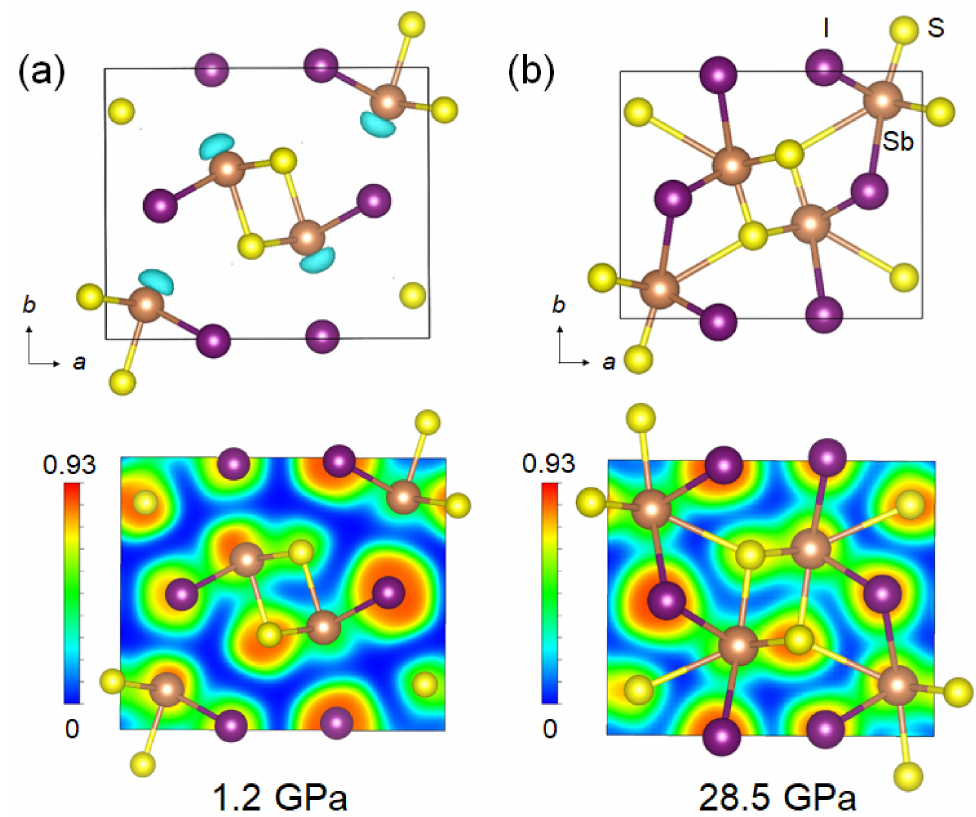
Figure 4. Electron localization function (ELF) of SbSI at different pressures. The calculated ELF plots and ELF in the (0 0 1) sections of SbSI at ( a ) 1.2 GPa and ( b ) 28.5 GPa. The isosurface value ranges from 0 to 0.93.